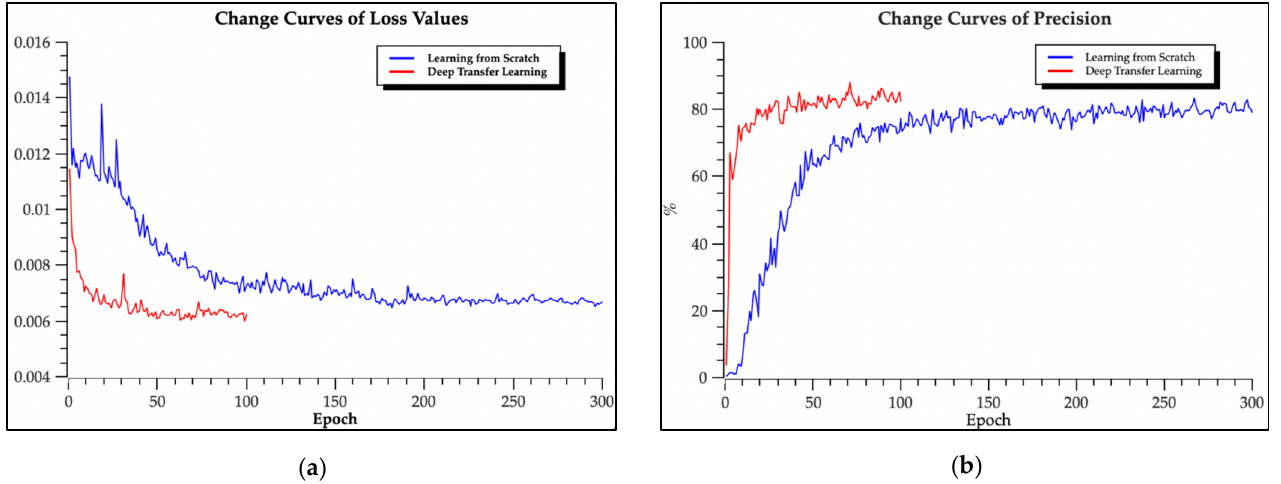
Figure 10. Training losses and precision curves of YOLOv5s-ViT-BiFPN based on learning from scratch and transfer learning with pretrained weights over the COCO dataset. ( a ) Change curves of loss values for YOLOv5s-ViT-BiFPN based on learning from scratch (blue line) and deep transfer learning (red line). ( b ) The change curves of precision for YOLOv5s-ViT-BiFPN based on learning from scratch (blue line) and deep transfer learning (red line).